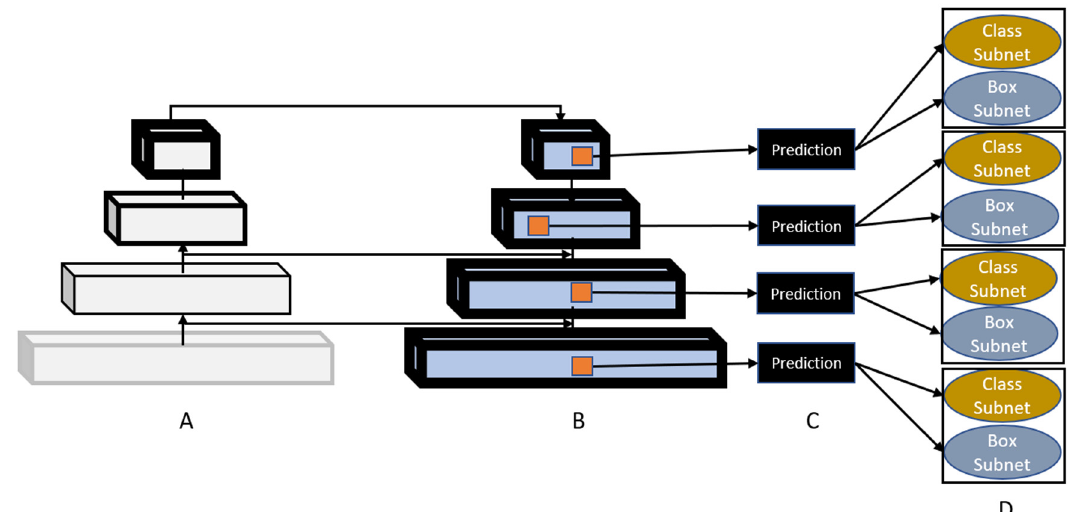
Figure 4. RetinaNet model architecture. ( A , B ) represent the FPN, with ( A ) consisting of a backbone model (in our case ResNet 50) that uses a bottom-up pathway to create feature maps at different scales from increasingly lower resolution data. The thicker the black outline on the boxes, the stronger the prediction. ( B ) is the top-down pathway, where feature maps are created from low-resolution data and enhanced with higher-resolution feature data from lateral connections (arrows) with the bottom-up pathway ( A ). Predictions made in ( C ) are divided into two components: Class and box subnets ( D ). Class subnets determine the probability of a given area containing an object. Box subnets label objects within class subnets.